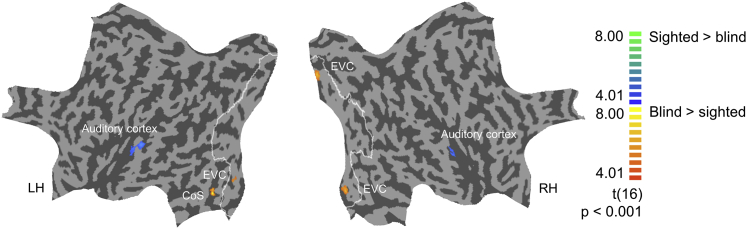
Results of the Whole-Brain Searchlight Analysis: Comparison between Blind and Sighted ParticipantsRegions in which classification accuracy achieved by the searchlight (cube with 7 voxels length—343 voxels in total) was different in the blind and the sighted. Warm-color hues indicate higher decoding accuracy in blind participants, whereas cold-color cues represent higher decoding accuracy in sighted participants. Data for sighted participants were taken from [1]. Threshold: p < 0.001 voxelwise, corrected for multiple comparisons using cluster extent. The searchlight analysis was performed in the volume space, and results are displayed on a standard flattened cortical surface reconstruction for visualization purposes. White outlines represent combined Brodmann areas 17 and 18, as defined by a BrainVoyager brain atlas. CoS, collateral sulcus; EVC, early visual cortex. See also Figure S4.